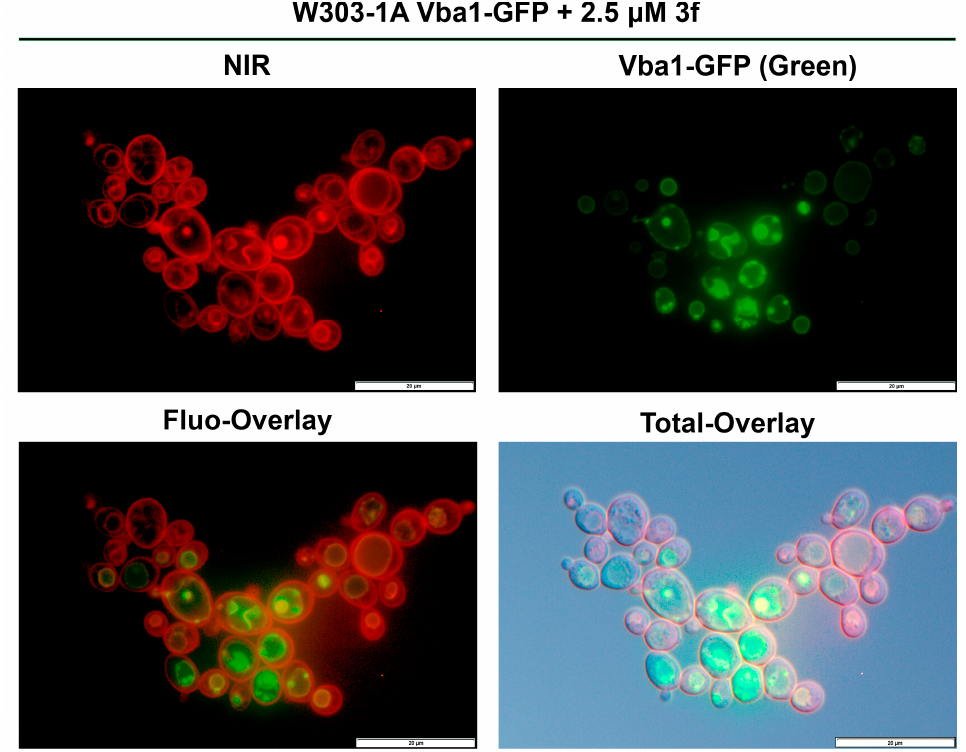
Figure 2. Co-localization of benzo[ a ]phenoxazinium chlorides 3a–f with vacuolar membrane. Fluorescence microscopy images of W303-1A Vba1-GFP cells after incubation with 3a–f (2.5 µM) for 1 h. Samples were rinsed two times in PBS 1× and mounted on a slide for observation with a 60× oil immersion objective, using the adequate filters U-FDICT, ET-CY5-FAR-RED (exciter filter: 595–645 nm/emission filter: 665–715 nm), and TLV-U-FF-FITC (exciter filter: 455–495 nm/emission filter: 505– 555 nm). Representative images of three independent experiments. Scale bar 20 µm.